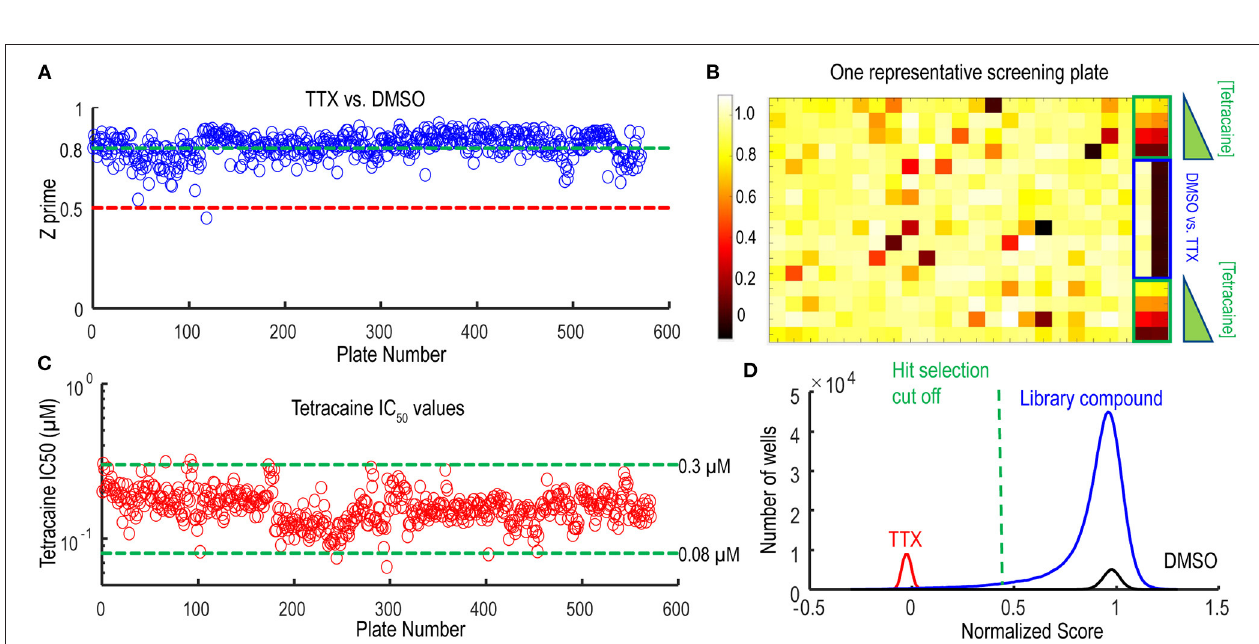
FIGURE 5 | Quality control metrics analysis for 200K Nav1.7 spiking HEK Swarm screen. (A) The Z ′ factor analysis for Nav1.7 Swarm screen. All 560 plates had Z ′ factors at or above 0.5. (B) The heat map of one representative screening plate. Column 1 through Column 22 contained library compounds. Columns 23 and 24 contained control compounds, including 8 wells of TTX and 8 wells of DMSO for Z ′ factor calculation and two 4-point titration series of tetracaine. (C) IC 50 values derived from the 4-point tetracaine titration for each screening plate. The IC 50 fluctuation was less than four-fold during the entire screen, indicating a high degree of assay consistency. (D) The histogram of library compounds and the control compounds. The normalized score of 0.45 was chosen for hit selection threshold, and based on this criterion, around 2,800 compounds were identified as hits from the 200K Nav1.7 Swarm screen.